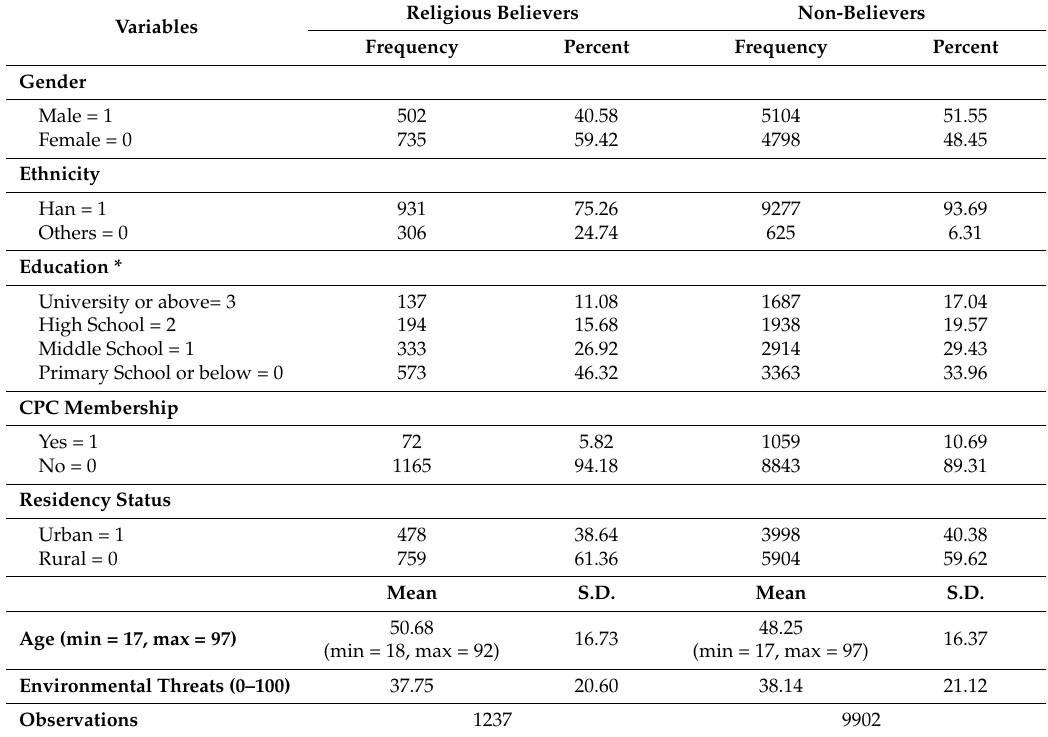
Table 3. Descriptive Statistics of Control